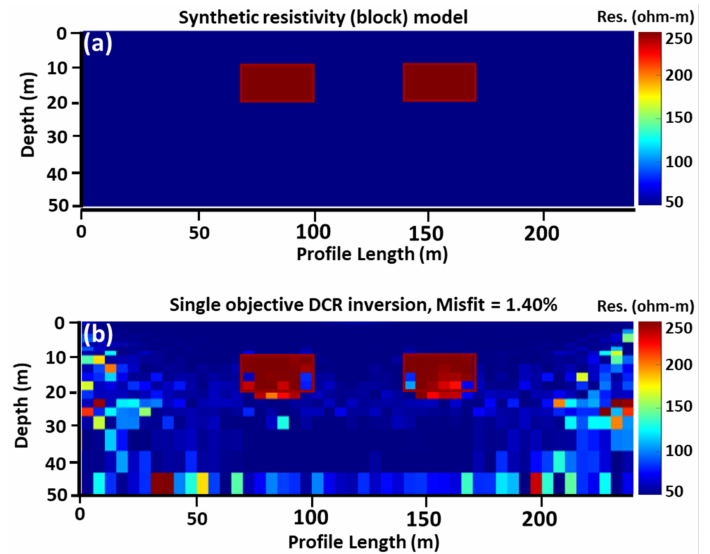
Figure 12. Positive anomaly model inversion using the single objective global optimization method; ( a ) synthetic dc-resistivity model and ( b ) single object inverted resistivity model. The dark red line is used to mark the anomaly